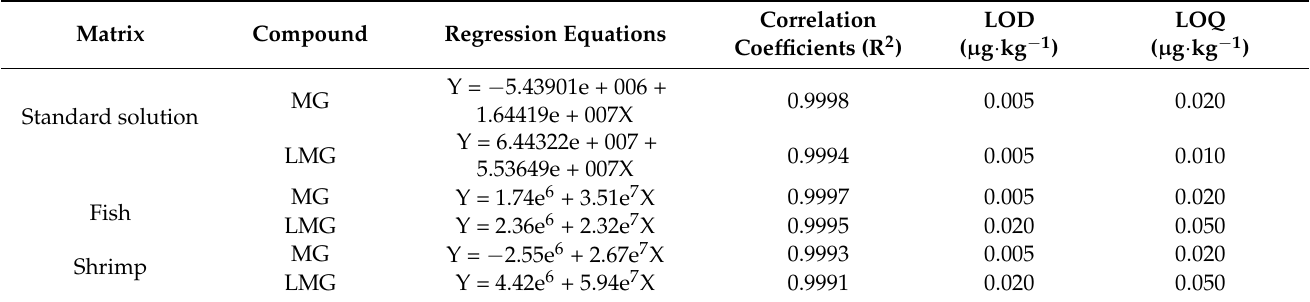
Table 1. Regression equations, LODs and LOQs of MG and LMG.